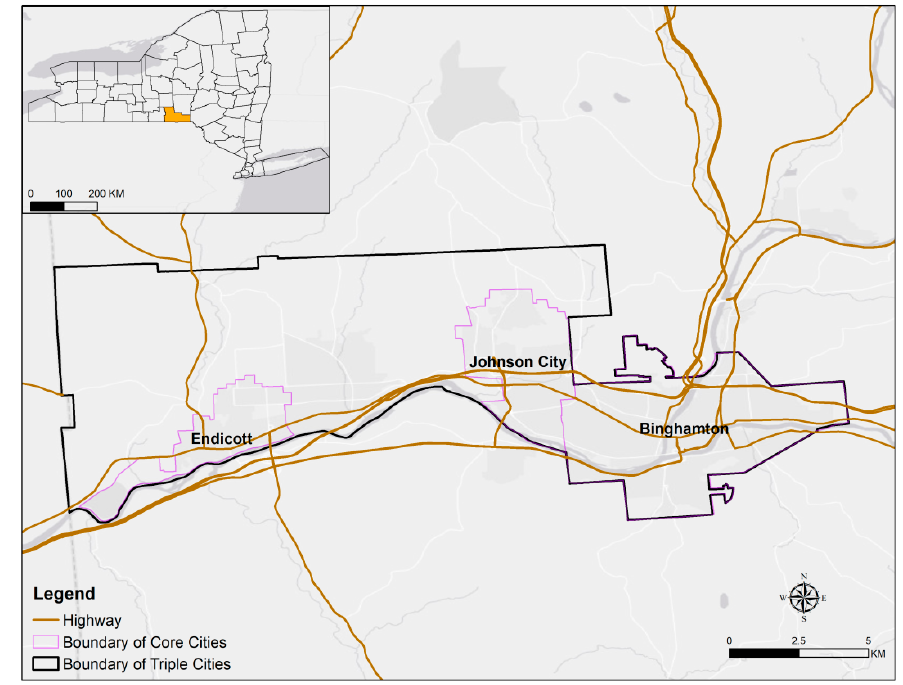
Figure 1. Study area of the Triple Cities (also known as the Greater Binghamton Area), New York.